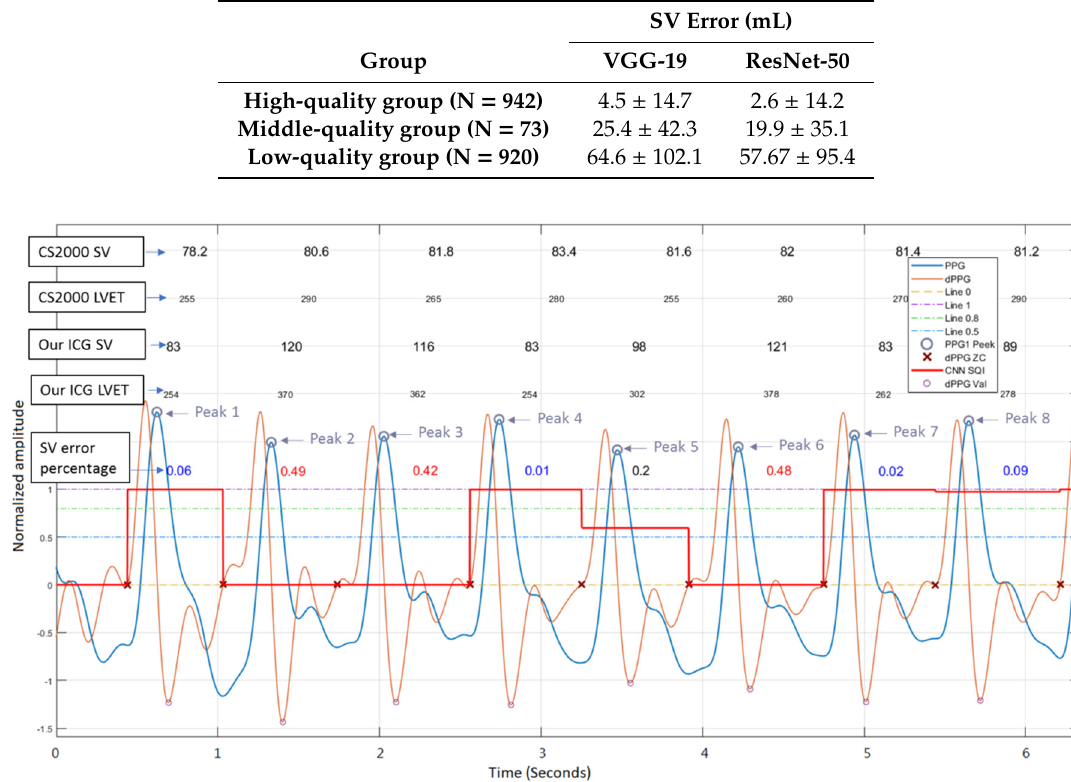
Table 5. The statistic errors of SV in the three groups as classified by the VGG-19 and ResNet-50 models.